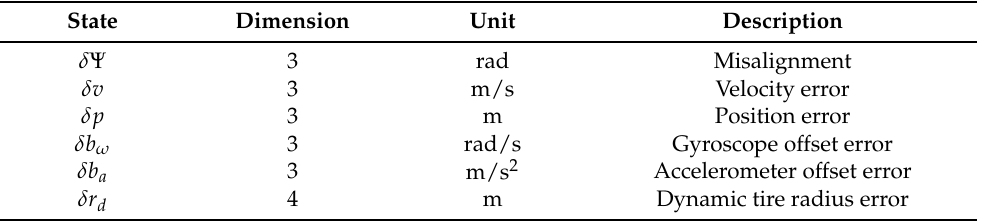
Table 1. States of error-state extended Kalman filter in fusion filter used for comparison of imple- mented integrity